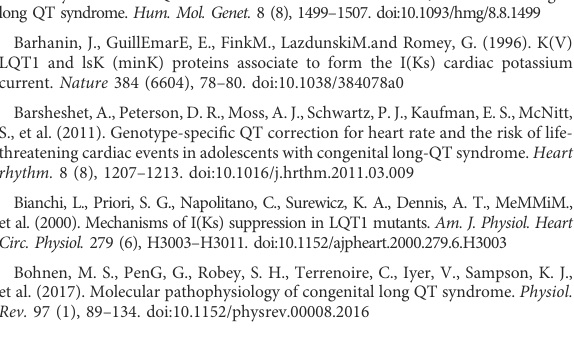
SUPPLEMENTARY FIGURE S1 Examples of currents elicited by step depolarization to +60 mV in cells expressing WT KCNQ1 (A) ; WT KCNQ1 expressed with WT KCNE1 (B) ; WTKCNQ1expressedwithKCNE1-L51H (C) ;andWTKCNQ1expressed with